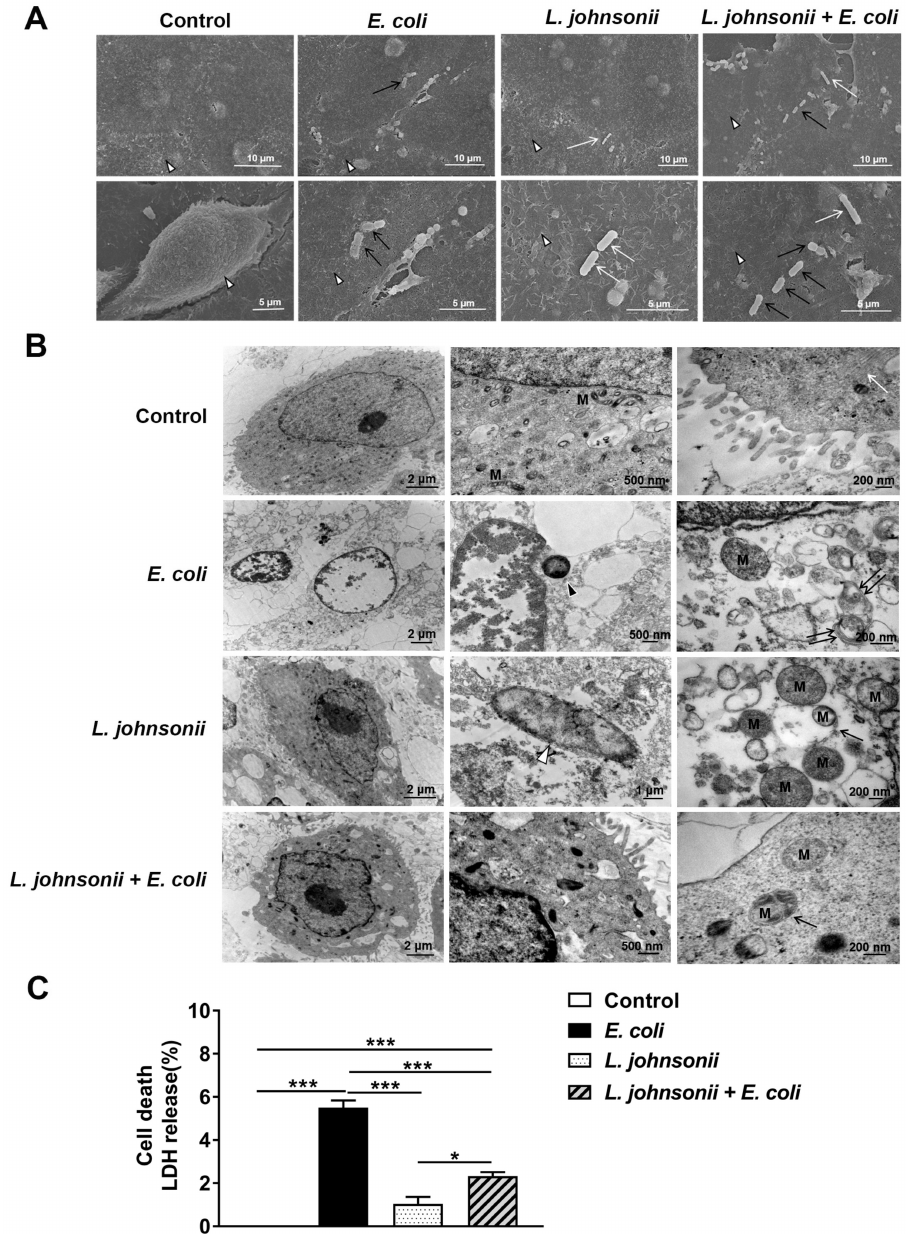
Figure 2. Pre-incubation with L. johnsonii L531 reduced E. coli -induced cell death and disruption of PMEC ultrastructure. PMECs were treated with medium alone (Control), mCherry– E. coli ( E. coli ), L. johnsonii L531 alone ( L. johnsonii ), or they were preincubated with L. johnsonii L531 for 3 h followed by E. coli challenge ( L. johnsonii + E. coli ). PMECs ultrastructure observed using SEM ( A ) and TEM ( B ). The subcellular structure of PMECs harvested from the cultured PMECs at 6 h after E. coli infection. In ( A ), white arrowheads indicate microvilli on the surface of PMECs, black arrows indicate E. coli and white arrows indicate L. johnsonii L531. In ( B ), black arrows indicate autophagosome with enclosing double membrane, M indicates mitochondria, white arrows indicate endoplasmic reticulum structures, black arrowheads indicate E. coli , white arrowheads indicate L. johnsonii L531, and double black arrows indicate marrow shaped structures. ( C ) LDH was applied to assay the PMECs death by detecting LDH levels in supernatants, which were collected from the indicated cells at 6 h after E. coli infection. Data were shown as the mean ± SEM of three independent experiments. * p < 0.05, *** p <